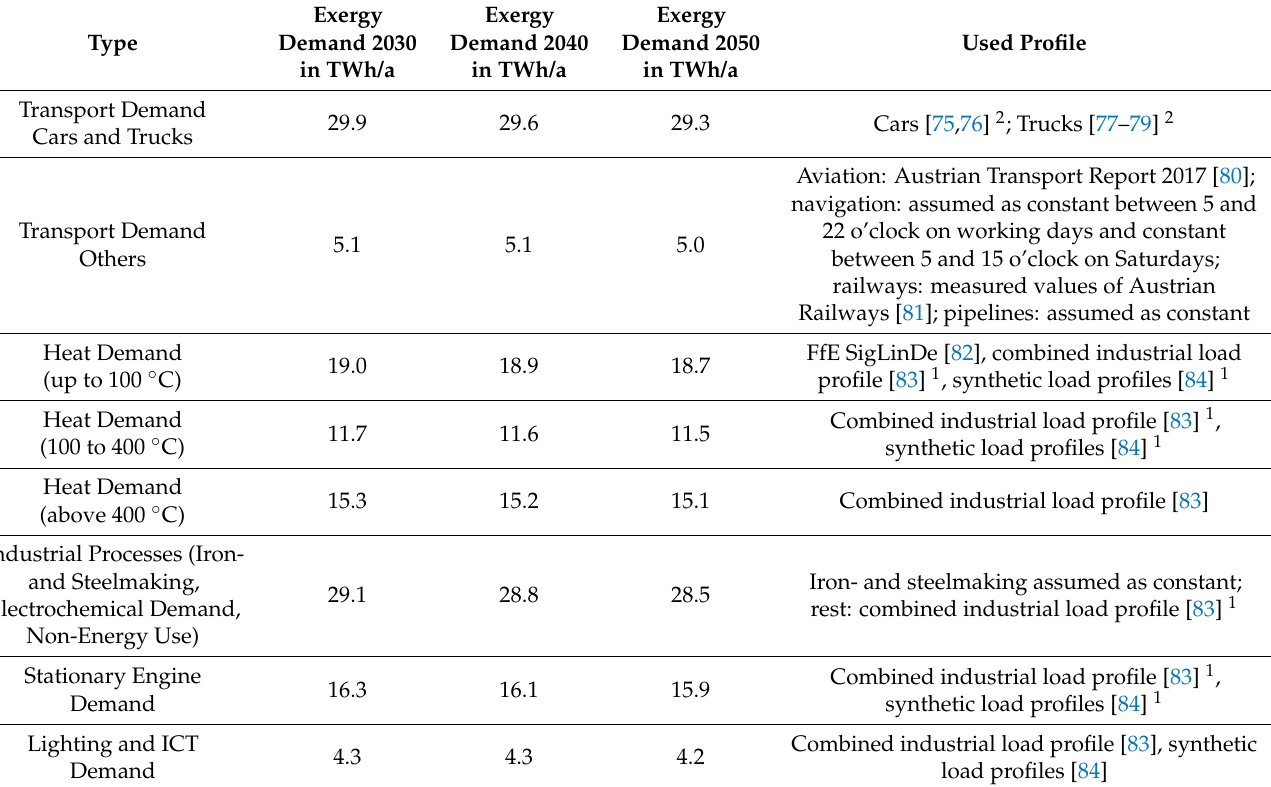
Table A1. Useful exergy demand for the scenario Energy Efficiency (calculation based on [25]).